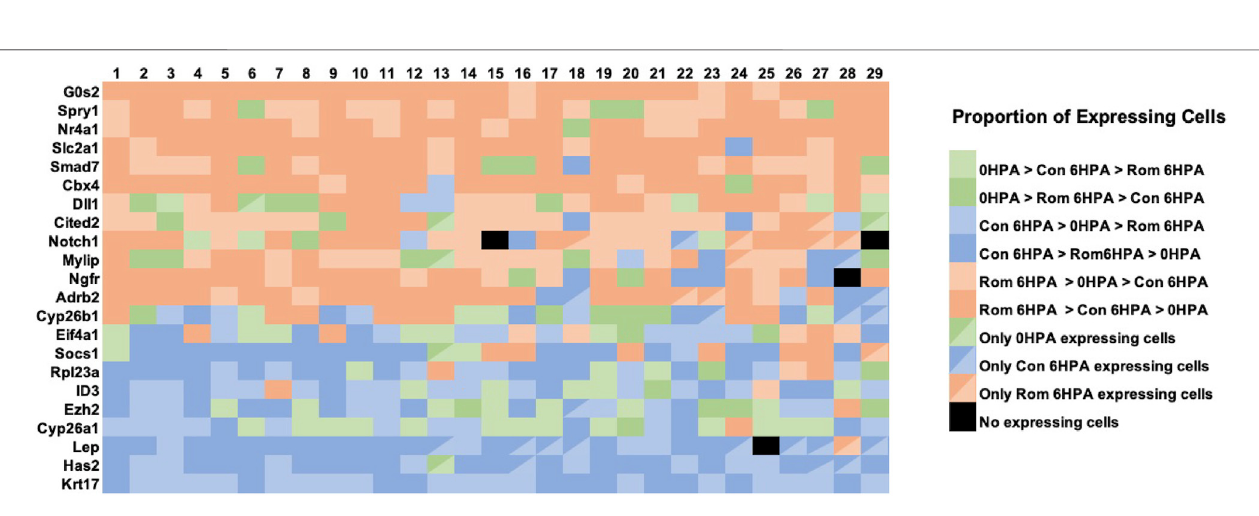
Frontiers in Cell and Developmental Biology |